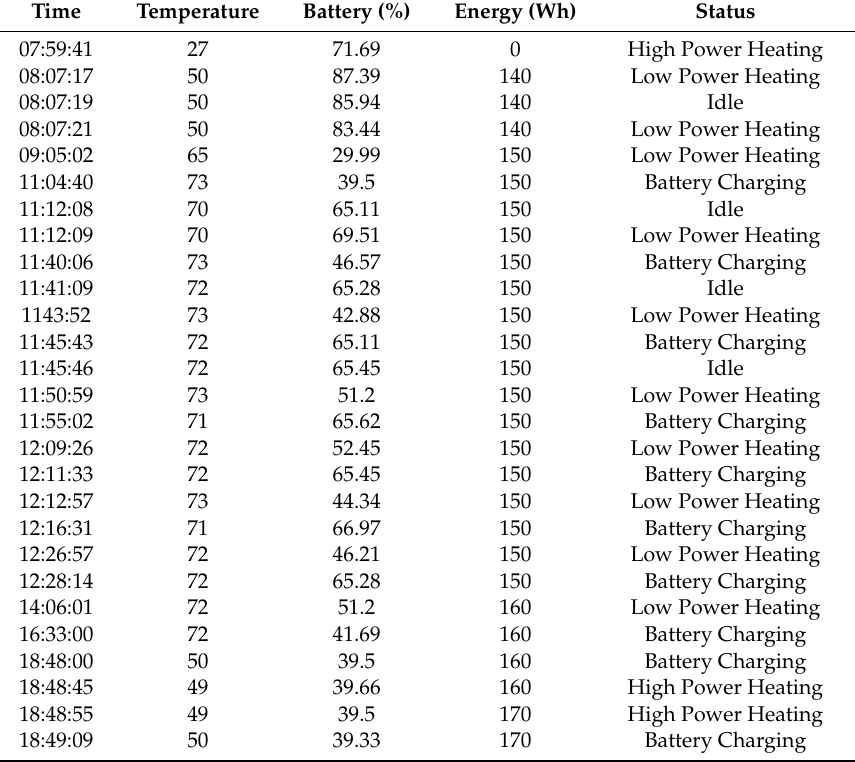
Table 1. Sample values that highlight the geyser performance during the presence of both national grid energy and solar energy.